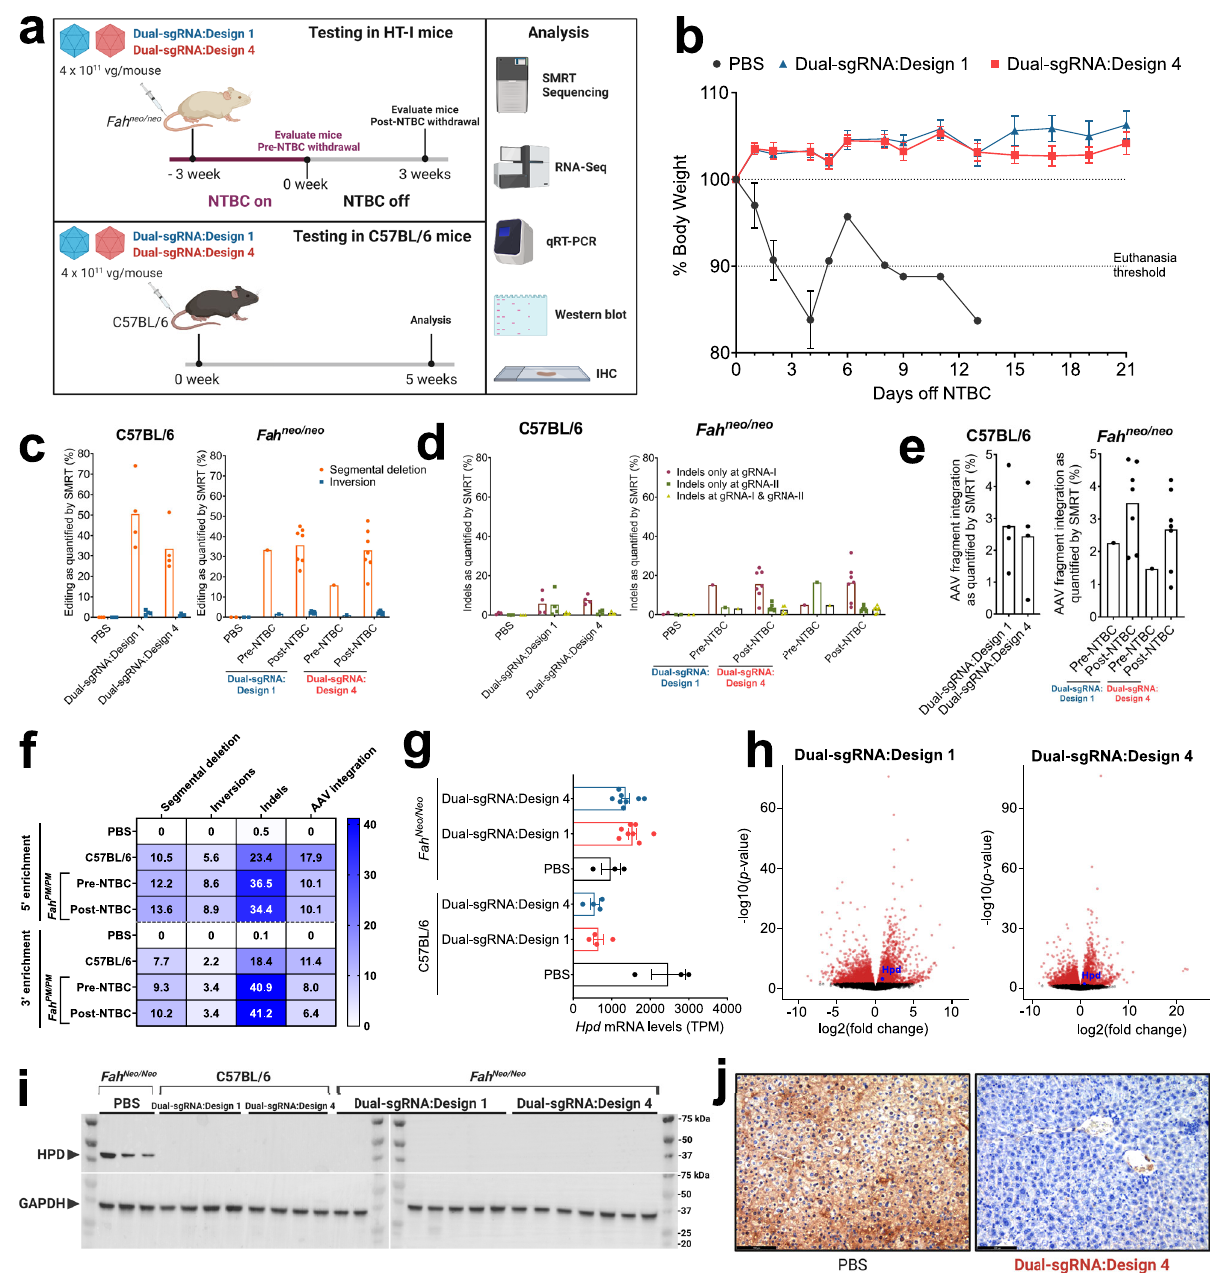
Fig. 2 In vivo gene editing using dual-sgRNA rAAV:Nme2Cas9 vectors. a In vivo experimental plan to validate rAAV:Nme2Cas9 Dual-sgRNA:Designs 1 and 4 to disrupt the Hpd gene by tail vein injections of AAV8 vectors in adult Fah neo/neo and C57BL/6 mice. b Complete rescue of body weights after Dual- sgRNA:Designs 1 and 4 in Fah neo/neo mice. c Quanti fi cation of editing events in C57BL/6 (left) and Fah neo/neo (right) mice by SMRT sequencing analysis showing ef fi ciencies of segmental deletion (orange) and inversion (blue) outcomes. d Bar graph showing the percentages of indels recorded in full-length (3.6 kb), UMI-corrected SMRT reads after Hpd editing by AAV8 delivery of Dual-sgRNA:Designs 1 and 4 in C57BL/6 (left) and Fah neo/neo (right) mice. The plot indicates indels recorded only at gRNA-I (in red), indels only at gRNA-II (in dark green), and indels at both gRNA-I and gRNA-II (yellow) as measured by SMRT sequence analysis. e rAAV fragment integration as detected by SMRT sequencing analysis. f Quantitation of editing events in UMI-corrected UDiTaS analysis reads after Hpd editing by AAV8 delivery of Dual-sgRNA:Design 4 in C57BL/6 and Fah neo/neo mice showing mean ef fi ciencies of segmental deletion, inversion, and AAV fragment integration. g mRNA levels from RNA-seq (transcripts per million) of Hpd wild-type mRNA in the livers of C57BL/6 mice and Fah neo/neo mice. h Volcano plots showing differentially expressed genes with false discovery rate ≤ 5% after adjusting for multiple comparisons (red; analysis detailed in Methods) between Dual-sgRNA:Design 1 and PBS-treated Fah neo/neo mice (left) and Dual-sgRNA:Design 4 and PBS- treated Fah neo/neo mice (right). i Total HPD protein knockout as shown by anti-HPD Western blot using total protein collected from mouse liver homogenates. This analysis of samples from multiple mice was performed once. j Representative images of immunostaining for HPD in liver tissues in Fah neo/neo mice injected with PBS (left) or Dual-sgRNA:Design 4 (right). Scale bar is 100 μ m. All mice in the cohort were examined once by this method (see Supplementary Fig. 2). Data were presented as mean values ± s.e.m. Sample size in panels b – g : ( n = 3 PBS-injected C57BL/6 mice; n = 4 Dual- sgRNA.Design 1 or 4 injected C57BL/6 mice; n = 1 in pre-NTBC Fah neo/neo cohort; n = 7 in post-NTBC Dual-sgRNA.Design 1 or 4 injected Fah neo/neo